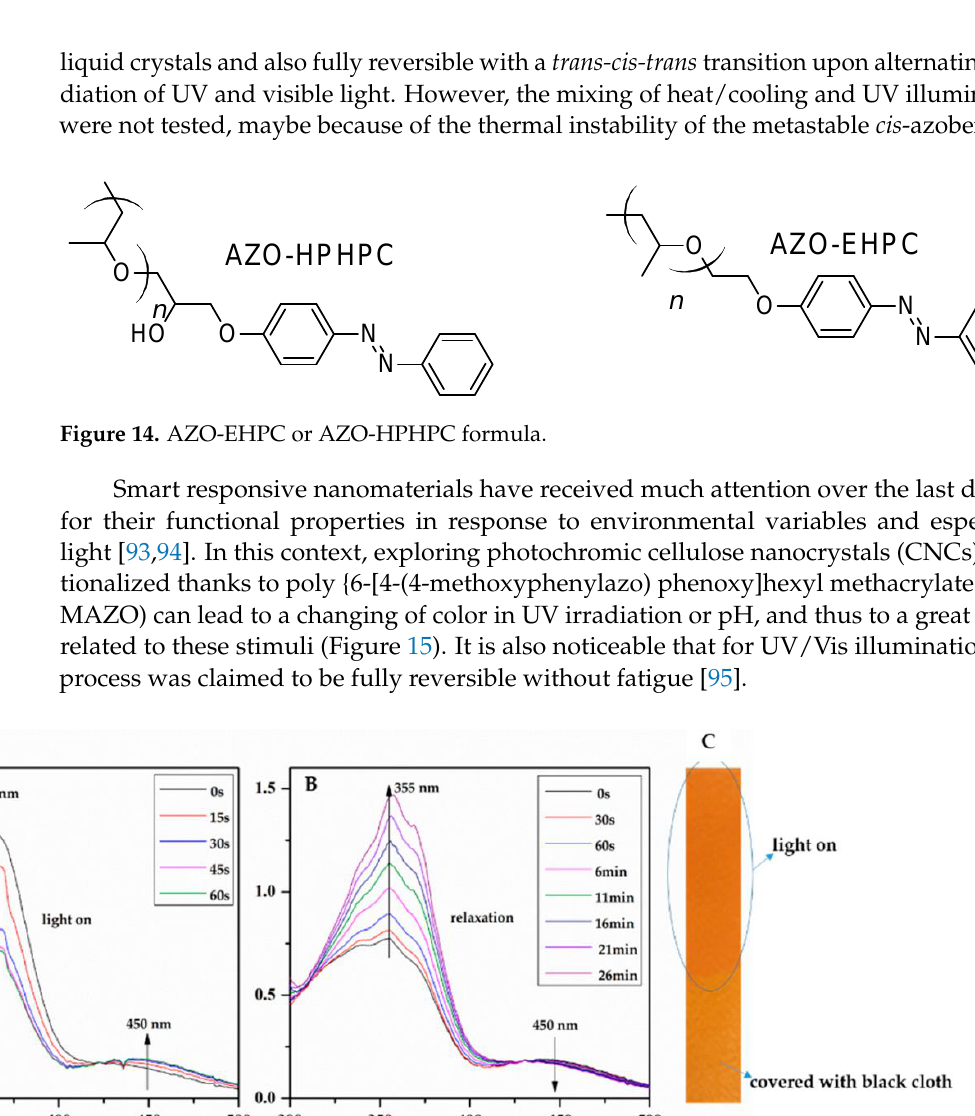
Table 1. Azobenzenic Schiff bases coupled on cellulose and UV protective properties.